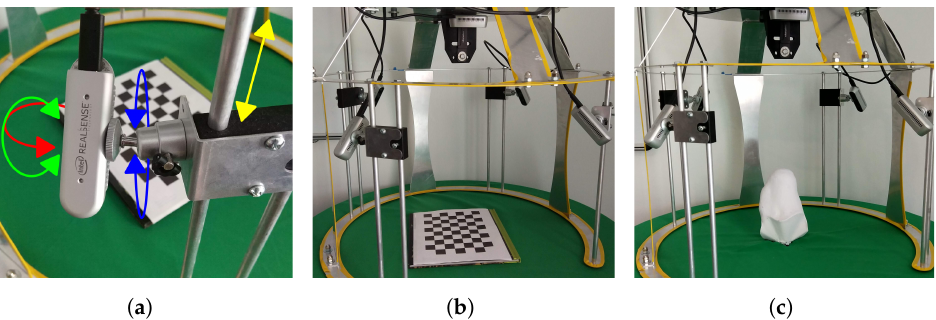
Figure 7. The configuration used for the plaster molds showing: ( a ) 4 cameras mounted on a support that enables rotation and positioning; ( b ) the workspace of the system being calibrated; and ( c ) the model being captured. Demonstrating the positions of camera mounts and their ability to change orientation to focus on the